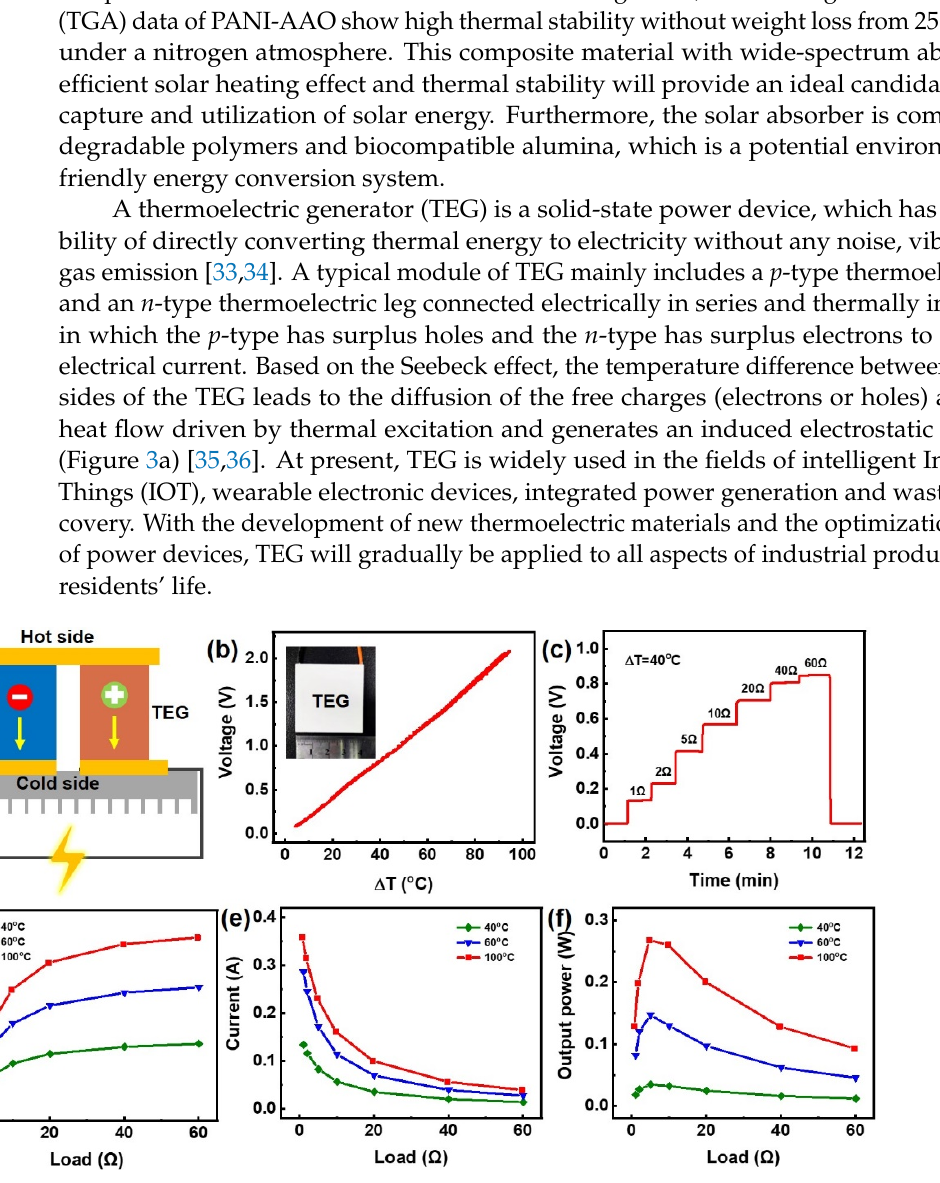
Figure 3. The output performance of TEG. ( a ) Schematic diagram of working principle of TEG. Output voltage of TEG as a function of temperature difference ( b ) and load ( c ). The output voltage ( d ), current ( e ) and power ( f ) of TEG under different temperature difference.